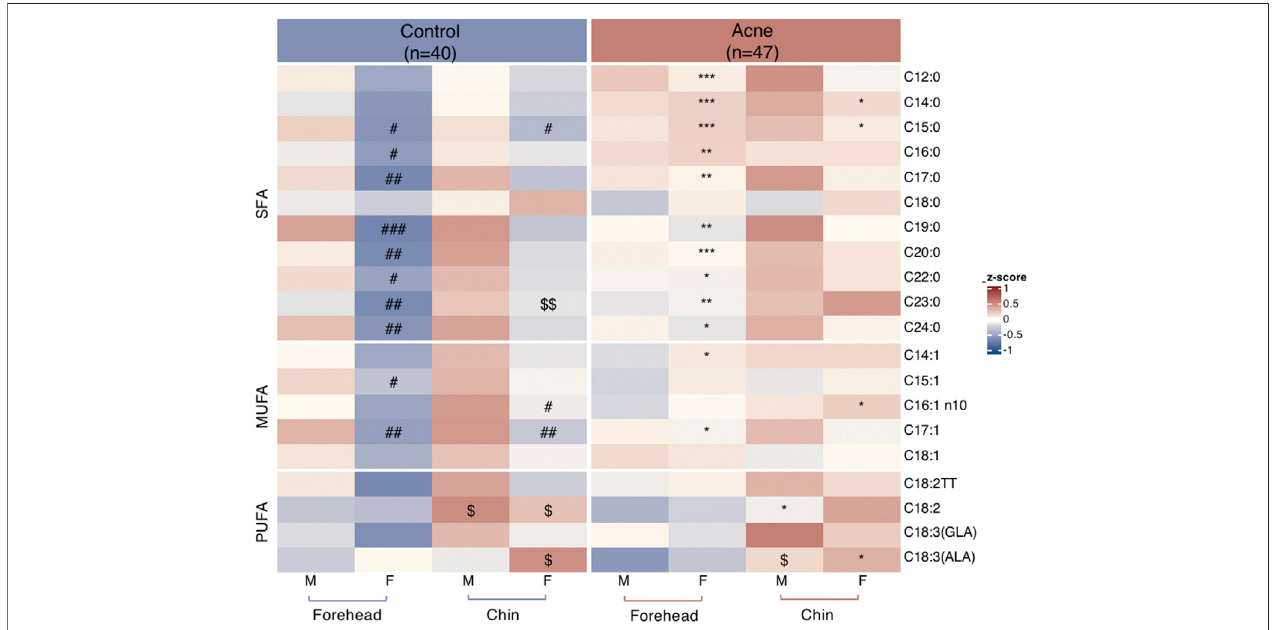
FIGURE 2 | Heatmaps of quanti fi ed fatty acids levels normalized by Z-score from sebum on forehead and chin between males (M) and females (F) in control and acne groups. * p < 0.05, ** p < 0.01, and *** p < 0.001 vs. the gender- and site-matched control group; # p < 0.05, ## p < 0.01, and ### p < 0.001 vs. site-matched male control group; $ p < 0.05 and $$ p < 0.01 vs. gender- and group-matched subjects.